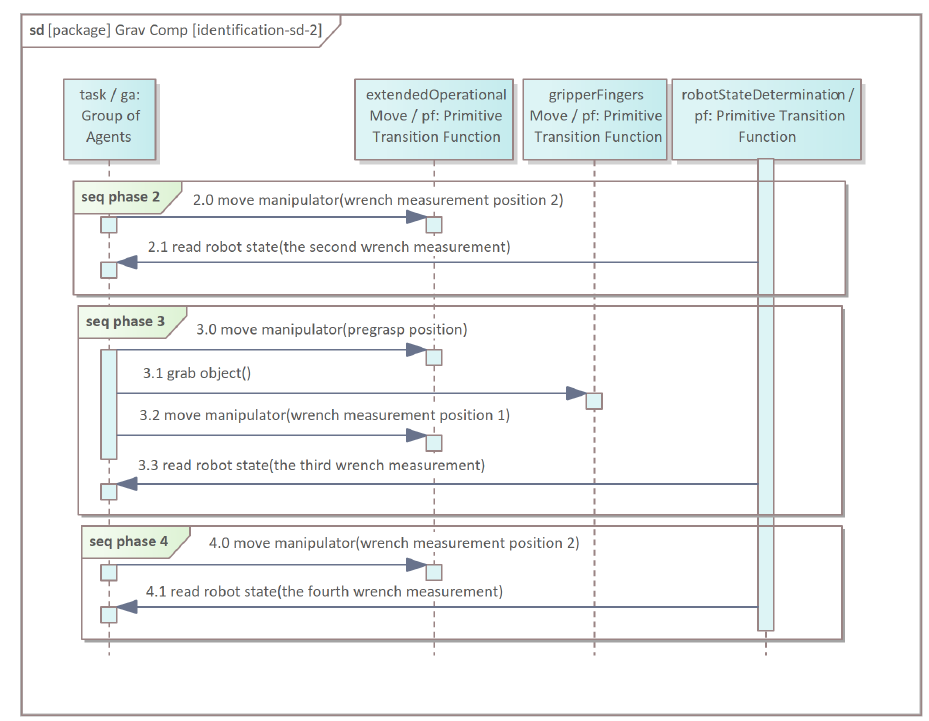
Figure 8. Identification procedure of grasped object parameters, where primitive transition functions relate to core/a.cs.pf—phases 2, 3 and 4.